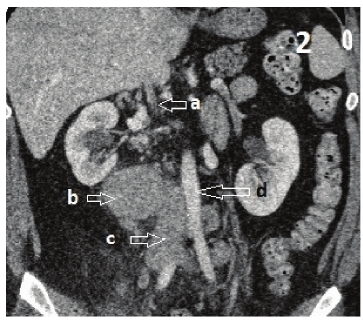
Figure 2: Abdomen CT coronal view: (a) atretic intrahepatic IVC, (b) IVC venous varix, (c) thrombosed IVC, and (d) aorta.